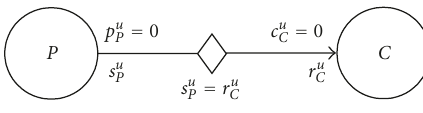
Figure 8: Notation of a global bu ff er.